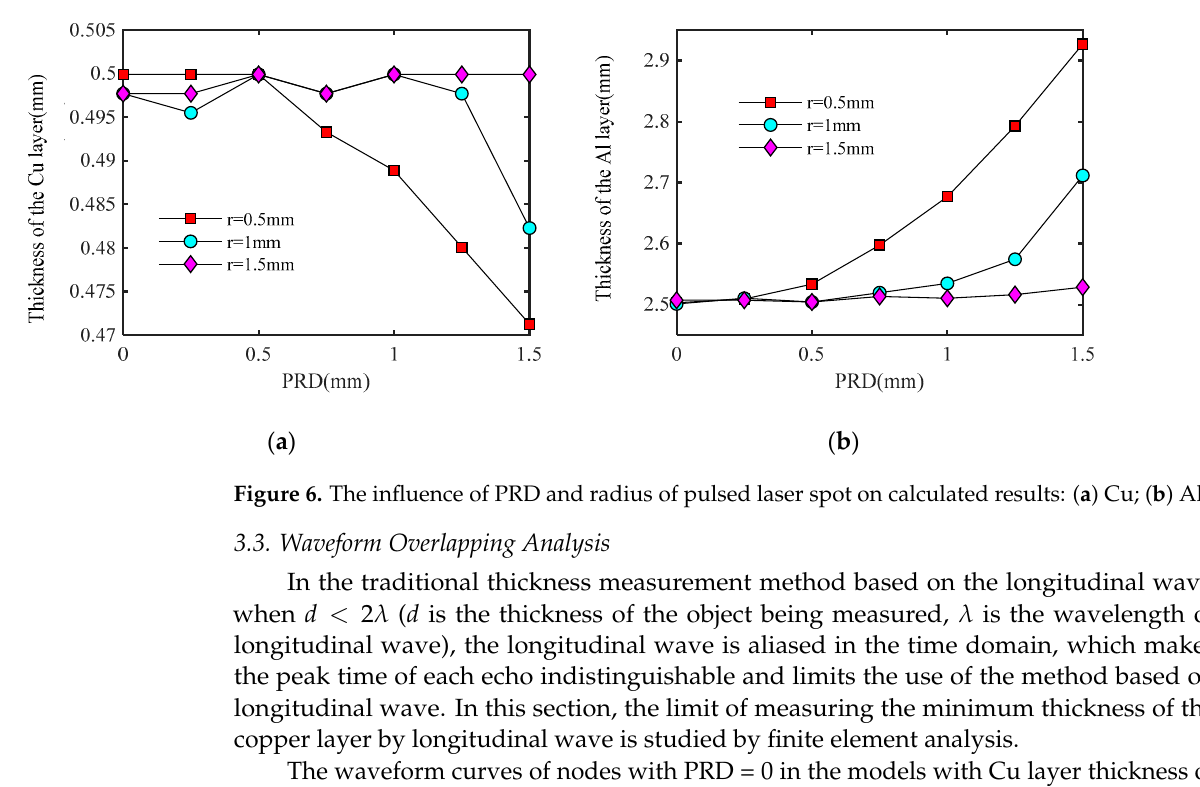
Figure 7. Waveform overlapping caused by thin copper layer. The arrival time of P 0 and P 1 in Figure 7 are extracted, and the thickness of the Cu layer is calculated according to Equation (10). The results are shown in Table 2. As the thickness of the Cu layer decreases, the relative error of the thickness of the Cu layer,